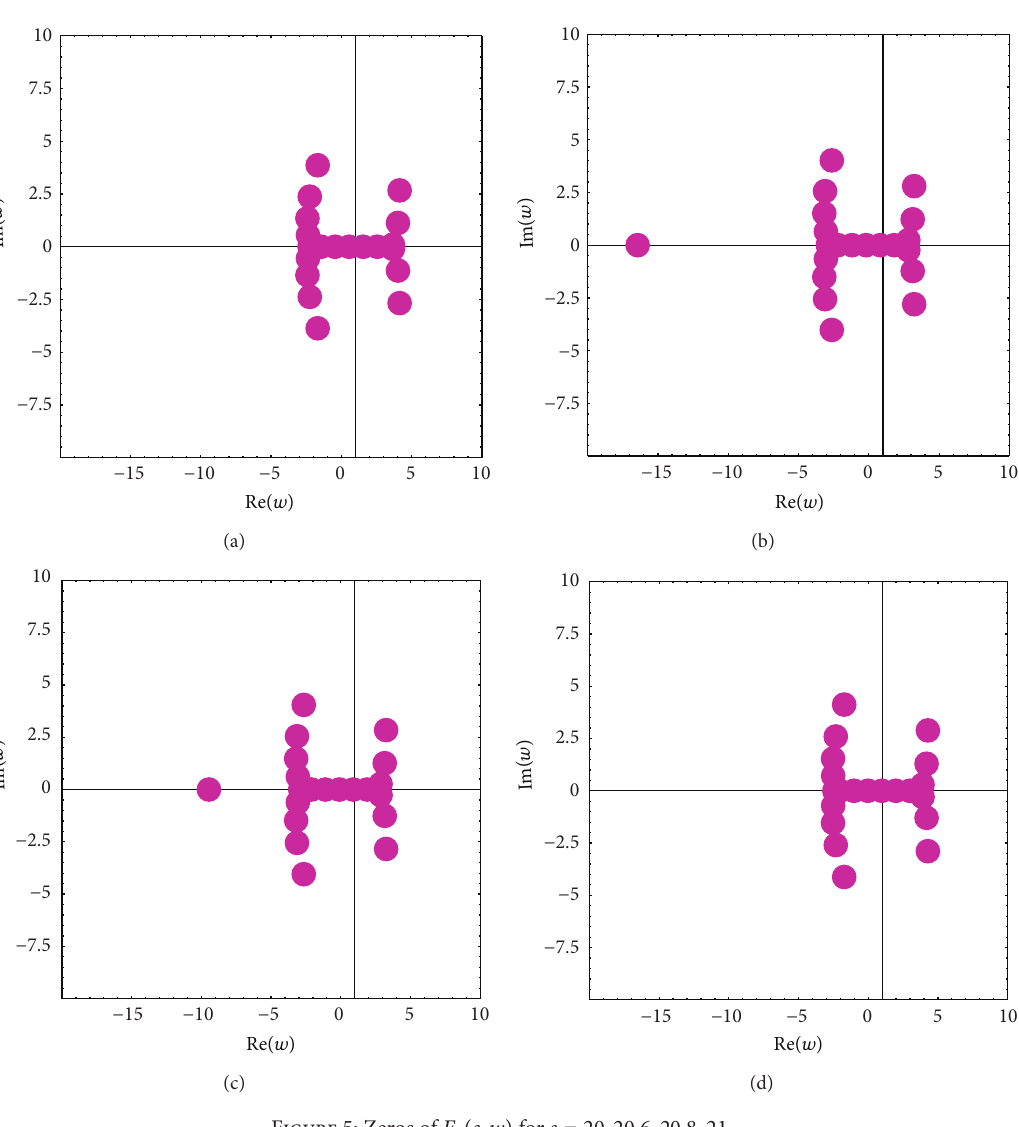
Figure 5: Zeros of 𝐸 𝑞 (𝑠,𝑤) for 𝑠 = 20, 20.6, 20.8, 21